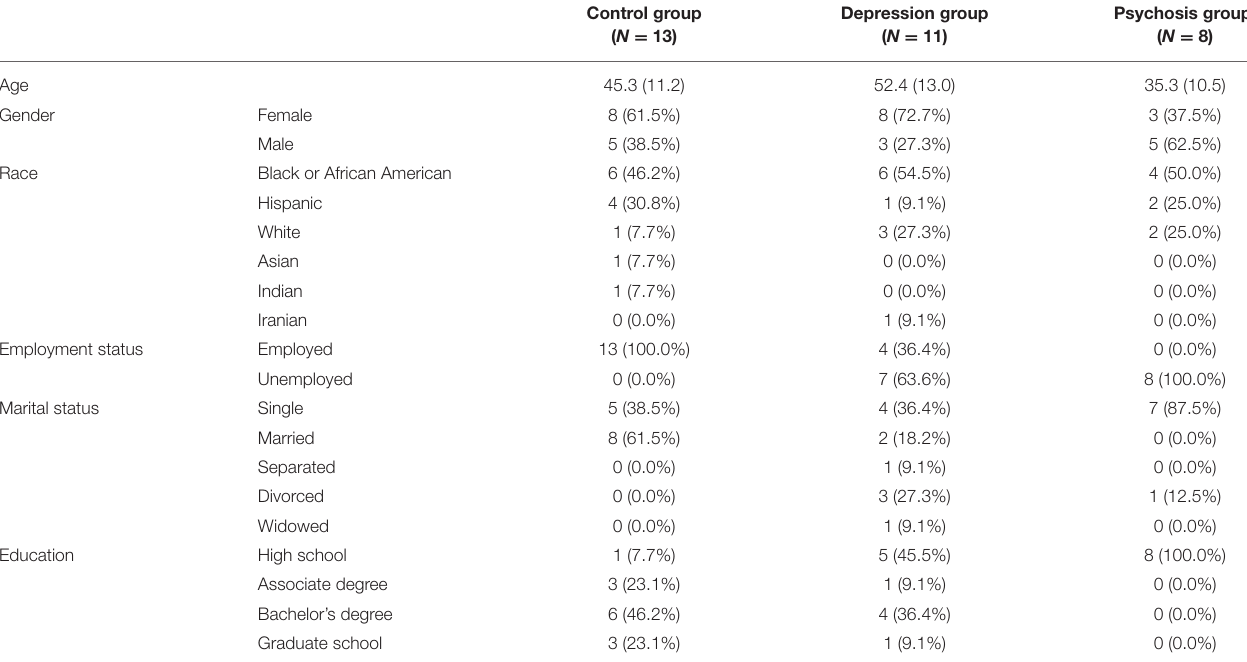
TABLE 1 | Participants